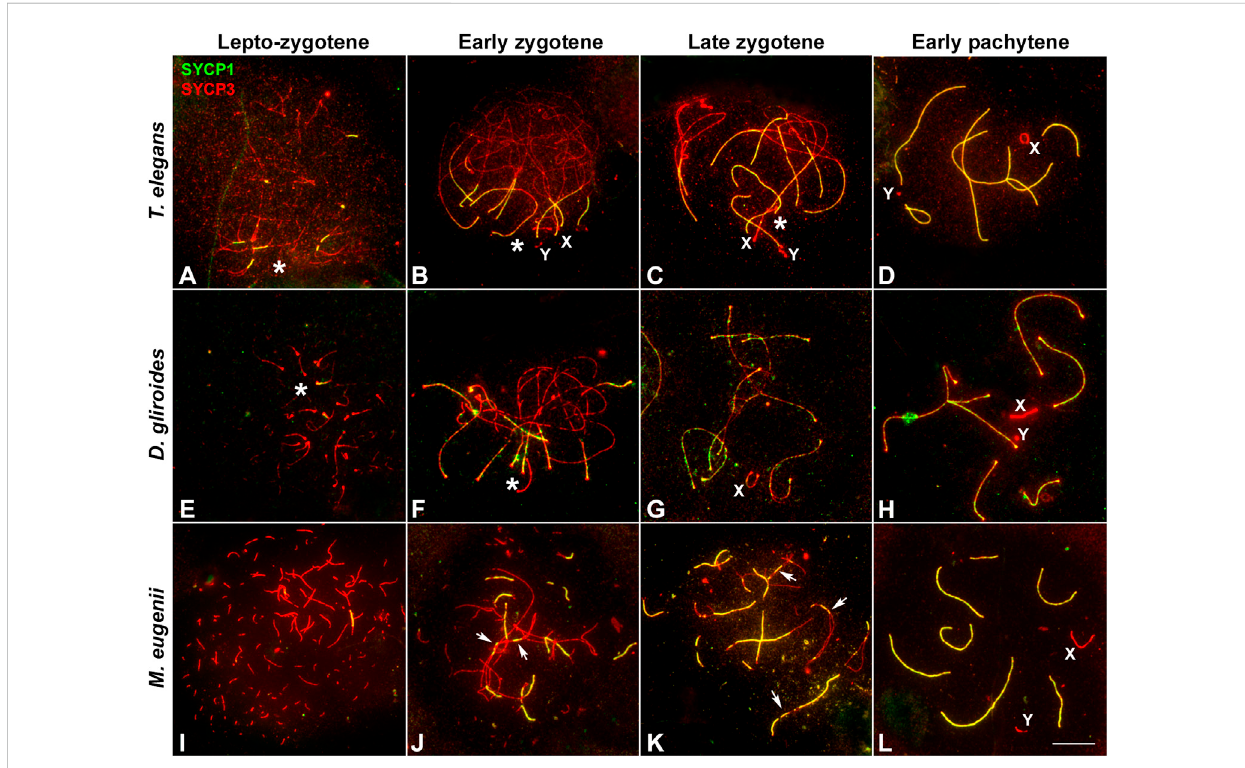
FIGURE 2 Synapsis progression during prophase (I) . Spread spermatocytes labeled with antibodies against SYCP3 (red) and SYCP1 (green). (A – D) . Thylamys elegans . Short fi laments of SYCP1 are seen between AEs at the leptotene-zygotene transition (A) . These fi laments appear mostly polarized to a speci fi c nuclear region, the bouquet area (asterisk). Synapsis progresses during early (B) and late zygotene (C) . Polarization of chromosomal ends is still observed (asterisks). Sex chromosomes (X, Y) lie in the bouquet region. Synapsis is complete at pachytene (D) except for the sex chromosomes. (E – H) . D. gliroides . Chromosomal ends are polarized to the bouquet area (asterisks) at leptotene-zygotene transition (E) and early zygotene (F) . Synapsis progresses during late zygotene (G) and is complete at pachytene (H) . Sex chromosomes remain separated. ( I – L ) Macropus eugenii . AEs appear as short fragmentsinthewholenucleusduringtheleptotene-zygotenetransition (I) .Atearlyzygotene (J) synapsisisinitiated bothatthechromosomesendsand at interstitial regions (arrows). This is also observed at late zygotene (K) . Synapsis is complete at pachytene ( L ), with sex chromosomes lying separately. Bar: 10 μ